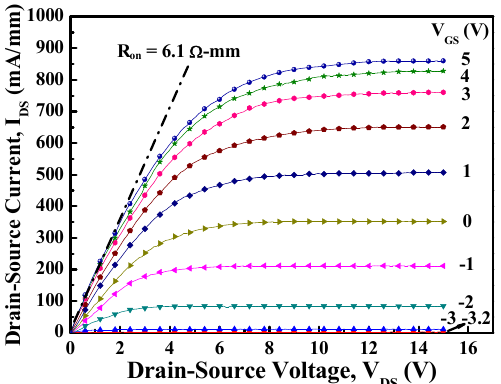
Figure 5. Typical drain − source current − drain − source voltage characteristics of MOSHEMTs with multiple-mesa-fin-channel array.